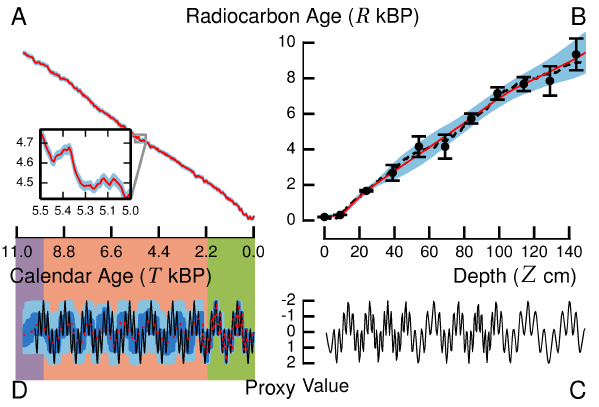
Figure 5. 14 C-dated synthetic lake sediment. Legend as in Fig. 4. Fig. 5. 14 C dated synthetic lake sediment. Legend as in Fig.4. (Color online.) (Color online.)